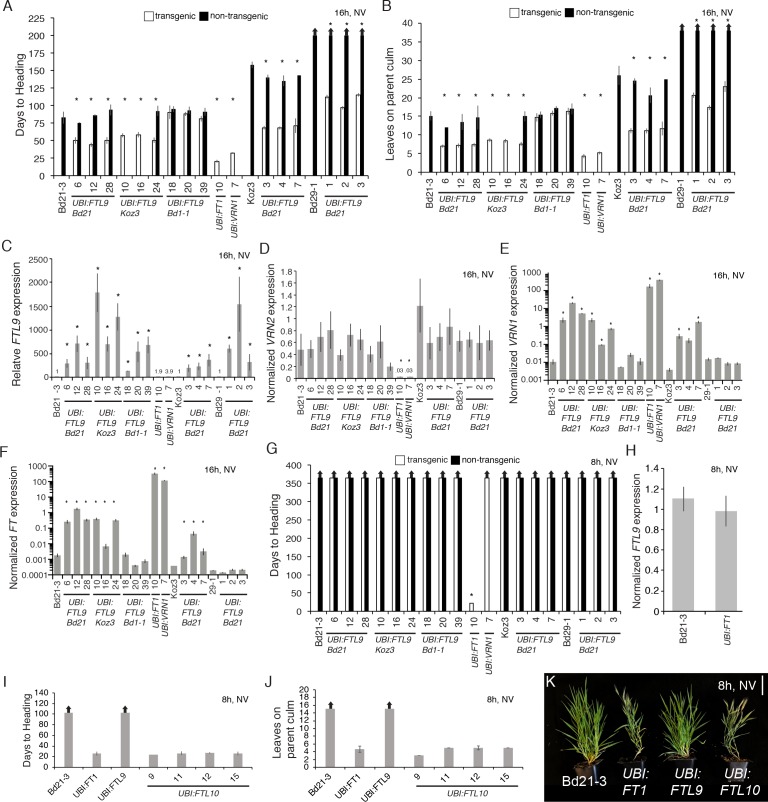
Effects of ubiquitin promoter-mediated constitutive expression of FTL9, FTL10, FT1, and VRN1.(A–B) Flowering times as days to heading (A) or final leaf count on parent culm at time of flowering (B) of independent UBI:FTL9 transgenic lines (white bars) in Bd21-3, Koz3, and Bd29-1 compared with the respective wild-types and segregating non-transgenics (black bars). Lines with no non-transgenic plants are fixed for the transgene. Bars represent the average of at least six plants ± SD. The experiment was repeated with similar results (data not shown). Arrows above bars indicate that none of the plants flowered at the end of the experiment. (C–F) Quantitative RT-PCR expression data from the upper leaf at the fifth leaf stage grown in a 16 hr photoperiod. Expression data are normalized to UBC18 and represent the average of three biological replicates ±SD. Expression analyses were repeated with similar results. Single asterisks indicate p-values < 0.01. NV, non-vernalized. UBI:FT1 and UBI:VRN1 transgenics are described in Ream et al. (2014). UBI:FTL9 Bd21 cDNA is from Bd21, UBI:FTL9 Koz3 cDNA is from Koz3 and UBI:FTL9 Bd1-1 cDNA is from Bd1-1. (G) Days to heading in 8 hr photoperiod non-vernalized (NV). Dissections on the parent culm revealed that the meristems were still vegetative after 150 days of growth in SD for all lines except UBI:FT1 which flowers rapidly. (H) Quantitative RT-PCR expression data from the upper leaf at the third leaf stage grown in a 8 hr photoperiod in UBI:FT1 and Bd21-3. (I) Flowering times as days to heading (J) or final leaf count on parent culm at time of flowering of 4 independent UBI:FTL10 T1 transgenic lines, UBI:FT1 (T2 generation) and UBI:FTL9 Koz3 line 10 from (A) in this figure (T1 generation). (K) Representative photo of Bd21-3 wild-type, UBI:FT1, UBI:FTL9, and UBI:FTL10 grown in a 8 hr photoperiod (SD). All over expression lines are in the Bd21-3 background. Bar = 5 cm. Photo taken after 80 days of growth.